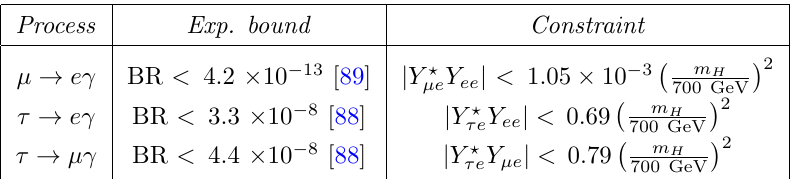
Table 6 . Constraints on Yukawa couplings as a function of heavy neutral scalar mass from ‘ (cid:11) ‘ (cid:12) + (cid:13) processes.